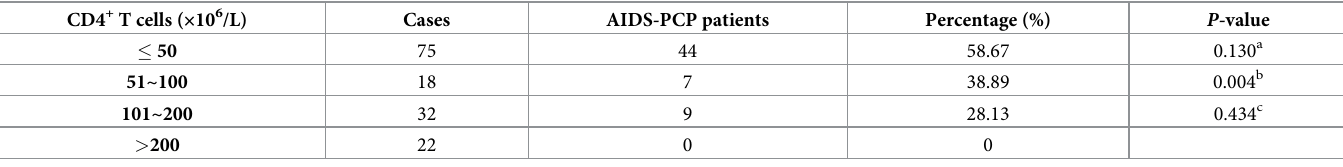
PCP: pneumocystis pneumonia; AIDS-PCP: AIDS-related PCP. a Comparison between groups with CD4 + T cell number � 50 × 10 6 /L and group with 51 × 10 6 /L–100 × 10 6 /L. b